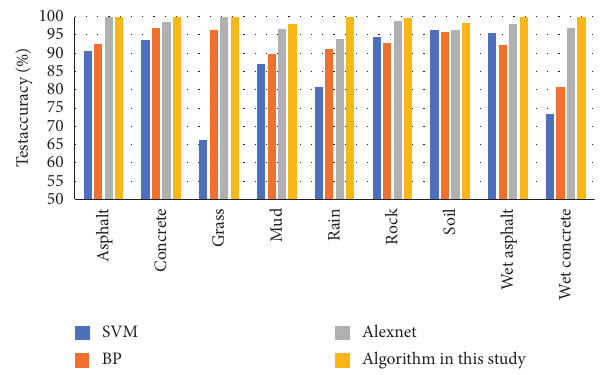
Figure 11: Test results of different pavement identification models. Table 6: Training time and individual image recognition time for different